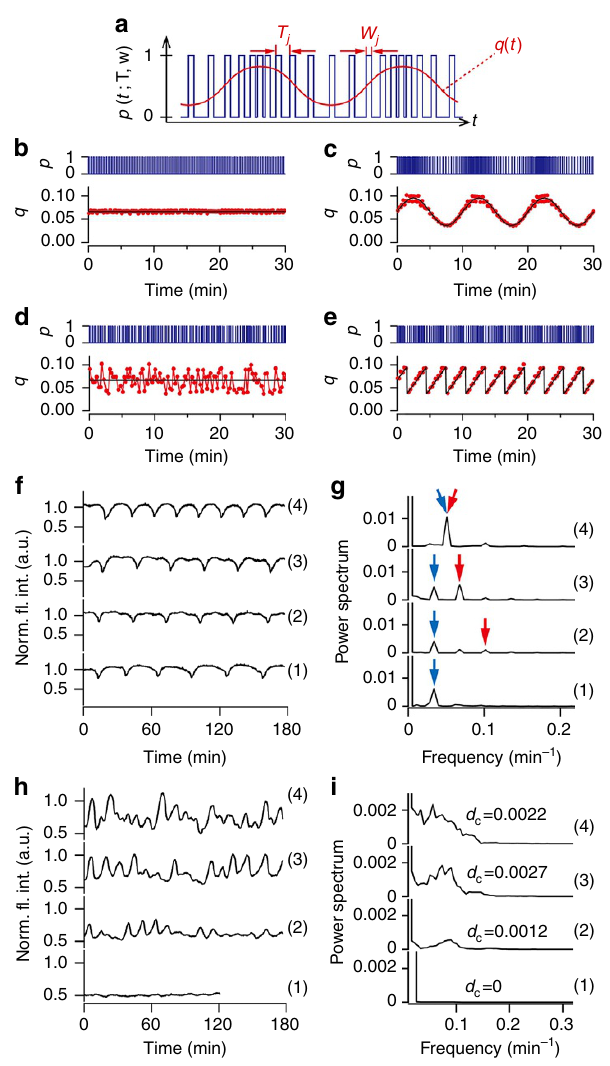
Figure 4 | Time-variable external control of chemical oscillation dynamics using the droplet open-reactor system. ( a ) Schematic diagram of the pulse-density modulation control of time-variable q ( t ). When the pulse train of p ( t ; T , w ) is denser, q ( t ) is higher, and vice versa. ( b – e ) Generation of p and q . Blue lines: pulse trains of p ( t ; T , w ); black lines: ( b , c , e ) theoretical curves of q ( t ) and ( d ) theoretical average of q ( t ); red dots and lines: q ( t ) generated in experiments, calculated as q ( t ¼ t j ) ¼ w j / T j . w j ¼ 0.99s (fixed for all j ). ( b ) Constant ( Z C ( t )). ( c ) Sinusoidal wave ( Z S ( t ),